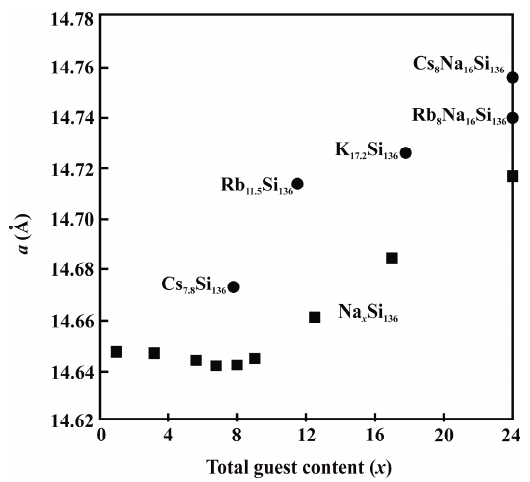
Figure 5. Lattice parameters versus M content, x for clathrate-I Na x Si 136 (0 < x < 24) [28], Na 24 Si 136 [16], K 17.2 Si 136 [19], Rb 11.5 Si 136 (this work), and Cs 7.8 Si 136 (this work), as well as ternary Rb 8 Na 16 Si 136 and Cs 8 Na 16 Si 136 [27].